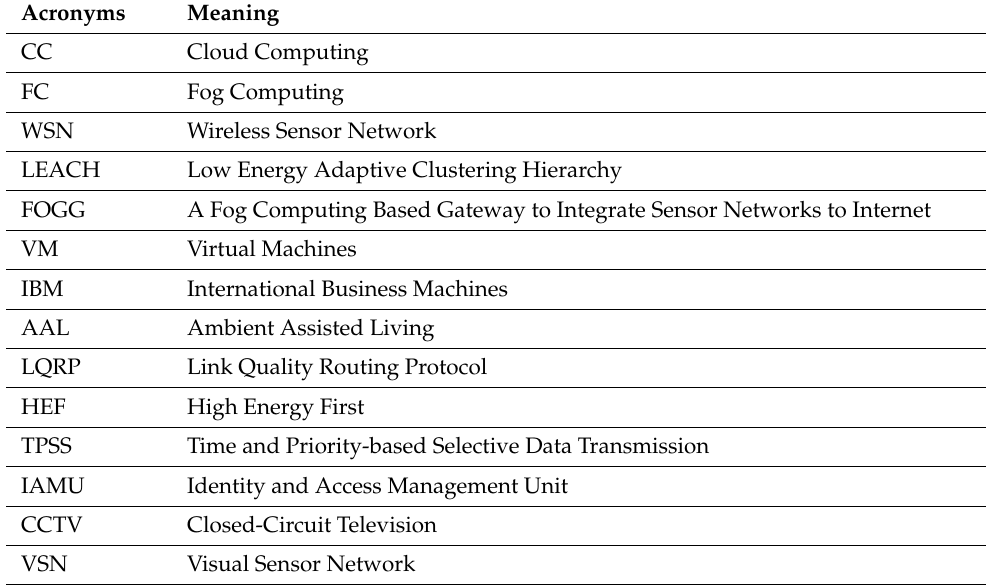
Table 6. Abbreviated